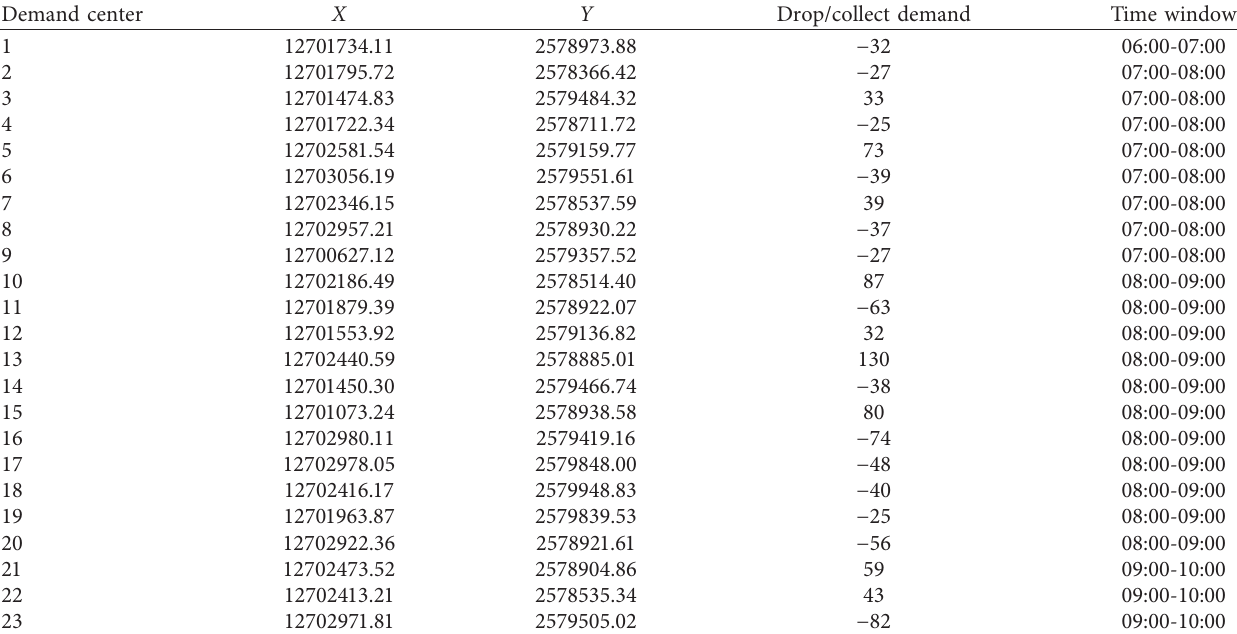
Table 4: The spatial coordinates and requirements of the demand center in the demo dispatch area. Demand